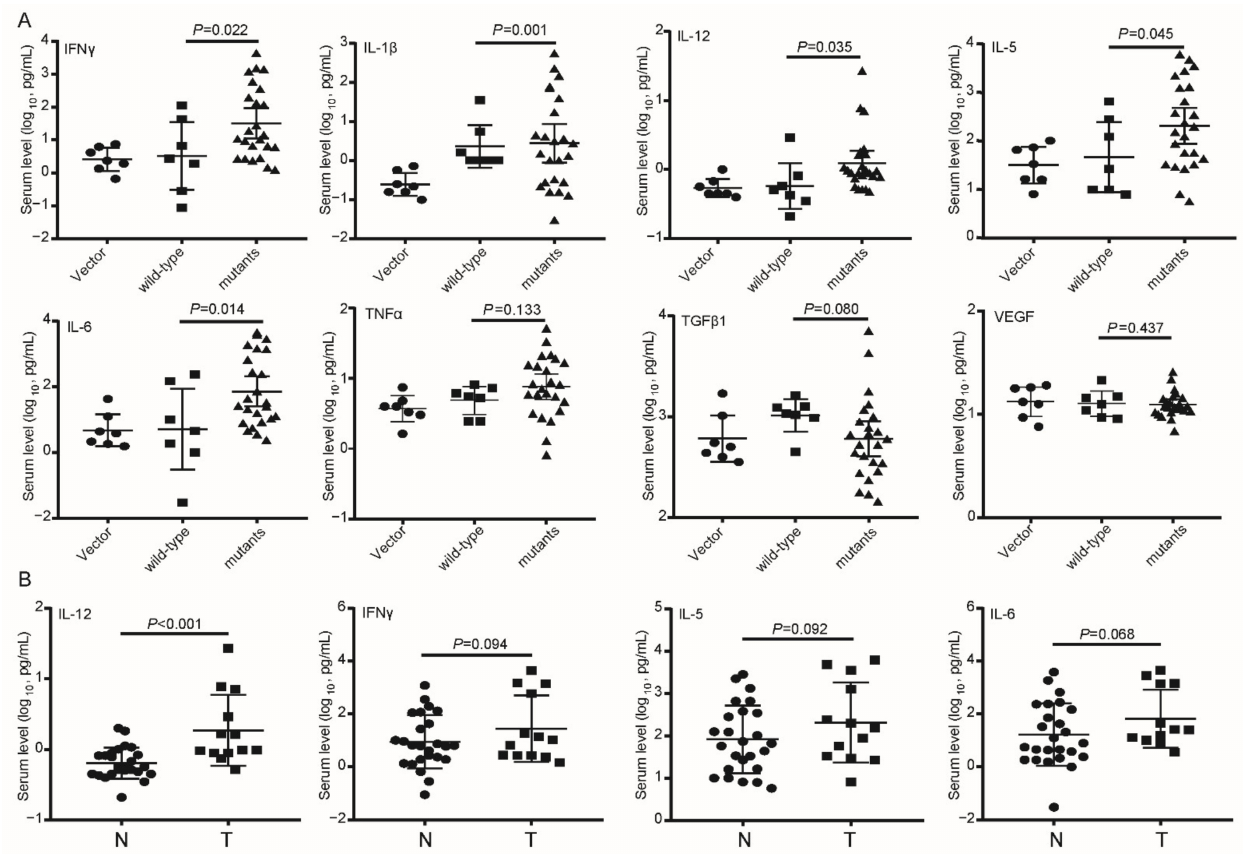
Figure 3. The expression levels of cytokines in mice serum. ( A ) The serum levels of IFN γ , IL-1 β , IL-12, IL-5, IL-6, TNF α , TGF β 1, and VEGF in the SB mice injected with empty vector, wild-type preS1/preS2/S fragment, or preS1/preS2/S mutants. ( B ) The serum levels of IL-12, IFN γ , IL-5, and IL-6 in the SB mice with tumor (T) or those without tumor